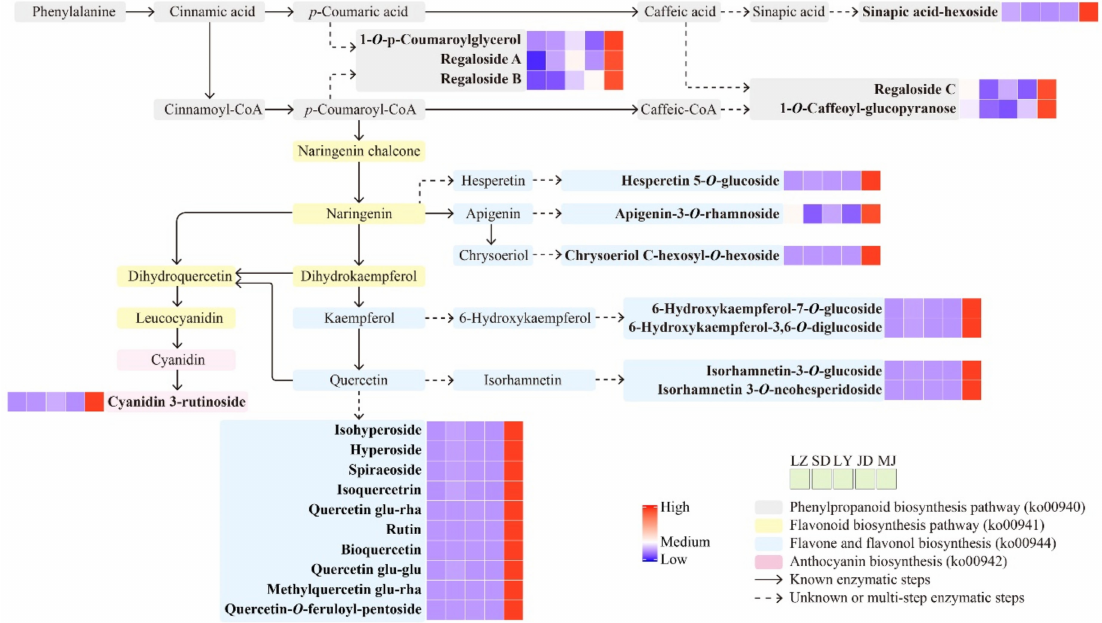
Figure 5. Upregulated differential phenolic acids and flavonoids (in bold) between purple L . regale (MJ) bulbs and edible white bulbs were mapped to the metabolic pathway networks. LZ: L . davidii var. willmottiae , SD: L . pumilum , LY: L . brownii var. viridulum , JD: L . lancifolium